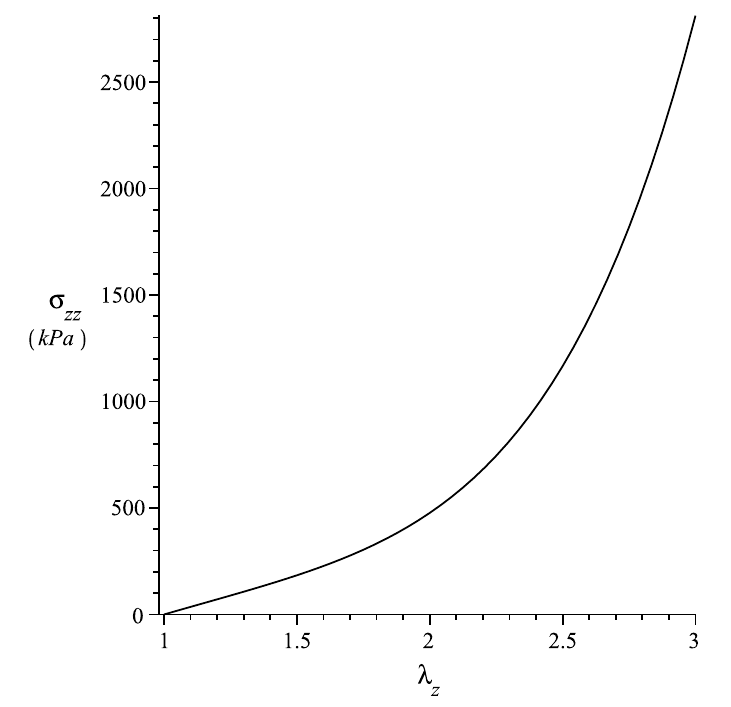
Figure 2. Axial stress σ zz vs axial stretch λ z . µ T = 120 kPa, β = 0, d 0 = − 3, d 1 =